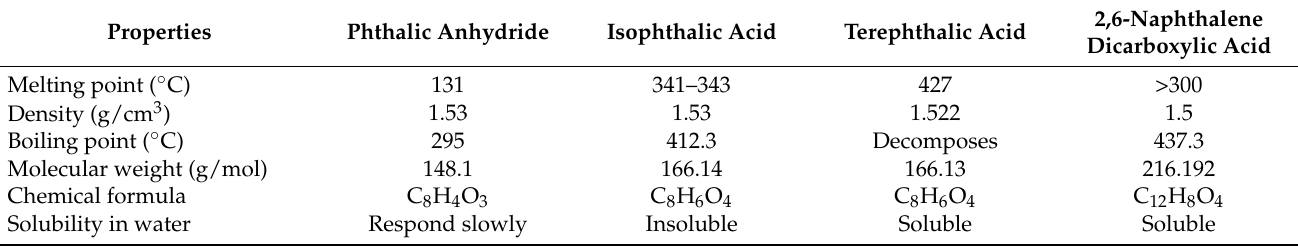
Table 4. Properties of aromatic polyester compound